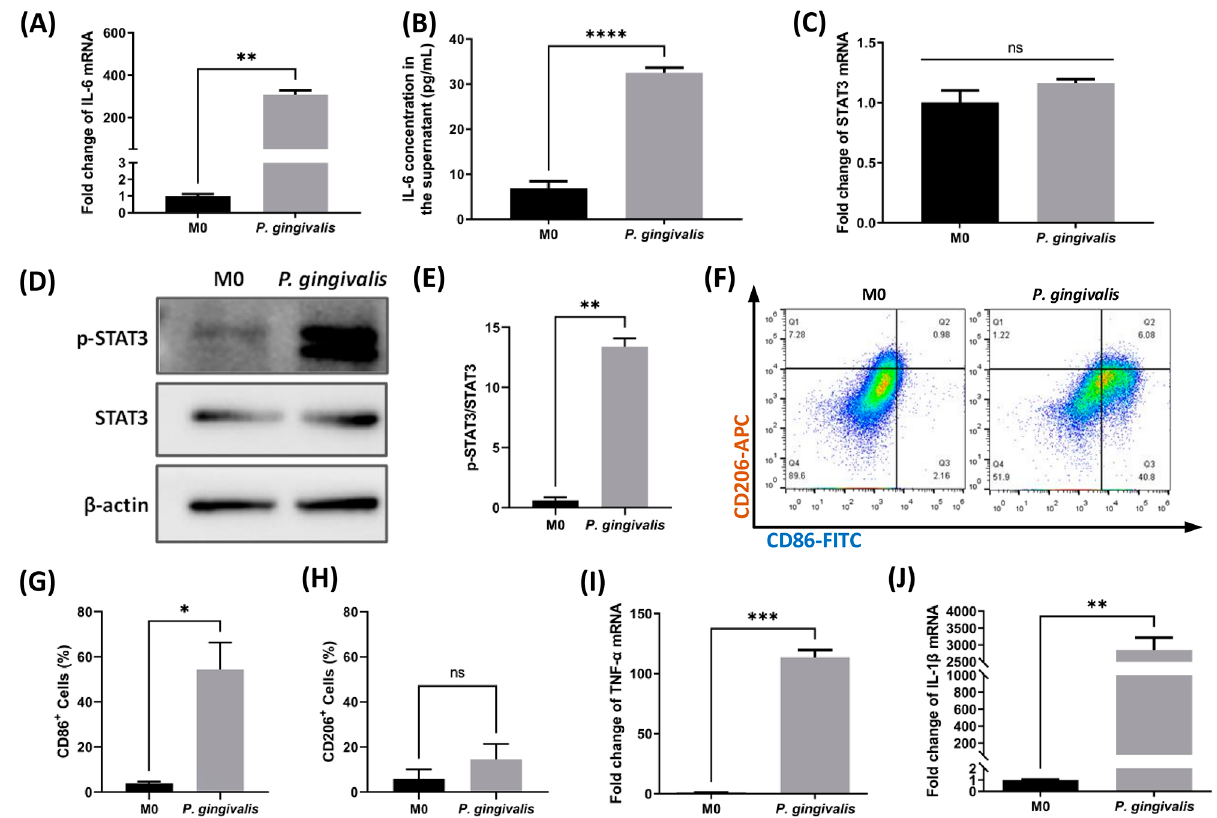
Figure 3- P. gingivalis infection induced IL-6 expression, STAT3 phosphorylation, and macrophage M1 polarization in BMDMs. (A-C) IL-6 transcription (A), IL-6 secretion (B), and Stat3 transcription (C) in response to P. gingivalis stimulation for 12 h. (D) and (E), p-STAT3 expression changes upon P. gingivalis activation. (F), representative flow cytometry results of unstimulated BMDMs (M0) and P. gingivalis - stimulated BMDMs. (G) and (H), statistical results for CD86+ (G) and CD206+ (H) macrophages in flow cytometry. (I) and (J), RT-qPCR results for expression levels of other M1 markers in response to P. gingivalis infection. M0, unstimulated BMDMs; P. gingivalis , BMDMs stimulated by P. gingivalis for 12 h. *p<0.05; **p<0.01; ***p<0.001; ****p<0.0001; ns, not